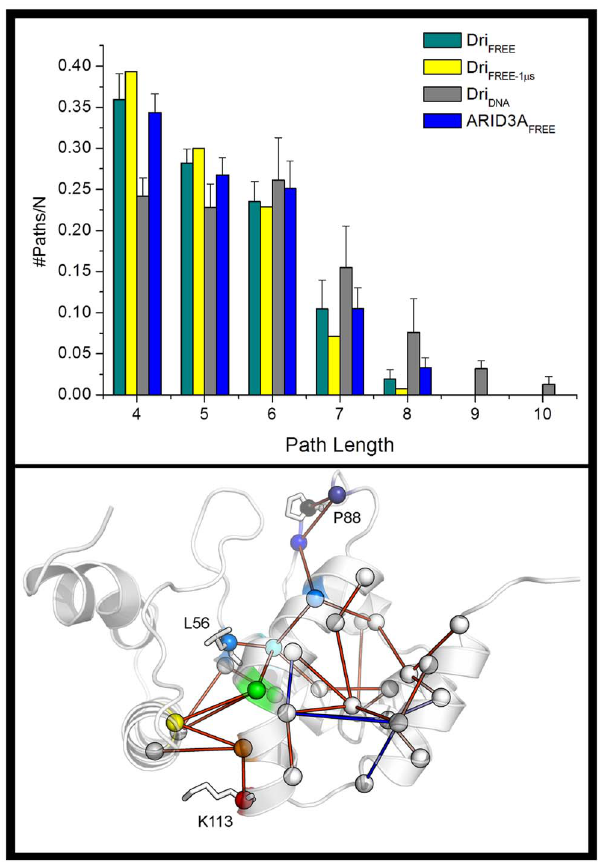
Figure 5. Long-range paths are promoted by DNA interaction in Dri simulations. Left panel ) Distribution of the shortest paths of communication identified by the PSN-LMI approach in the different simulations employed in this study. Average values from the different replicates of the same system are shown. Right panel ) Differences among the paths of length higher than 8 residues (starting and final residues included) in Dri DNA and Dri FREE simulations. The paths that are present only in Dri DNA or Dri FREE simulations are shown as red and blue cylinders, respectively. Nodes of the paths are shown as spheres centered on the C a atom. The nodes belonging to the paths from K113 to both L56 at the base of L1 (K113 R Y109 R L32 R L106 R F28 R L56) and L87-I91-P88 in L2 (K113 R Y109 R L32 R L106 R L59 R L98 R L87- R I91 R P88, Dri numbering) are highlighted by different shades of colors from red to blue/black. K113, L56 and P88 are shown as